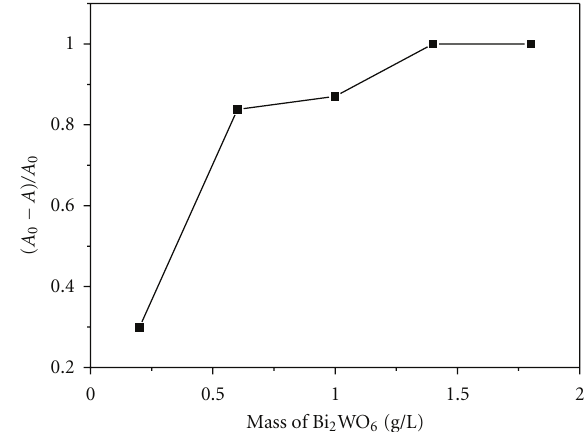
Figure 6: The e ff ect of the concentration of photocatalyst on the degradation e ffi ciency.